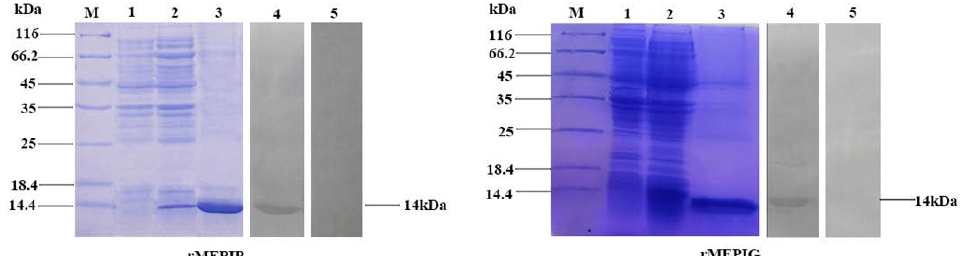
Figure 4. SDS-PAGE and Western blot analysis of the reactogenicity of rMEPIP and rMEPIG. Lane M: molecular mass marker; Lane 1: negative control without IPTG induction; Lane 2: E. coli induced with IPTG; Lane 3: purified recombinant protein; Lane 4: Western blot analysis using flounder anti- S. iniae serum; Lane 5: non-immune flounder serum was used as a negative control.